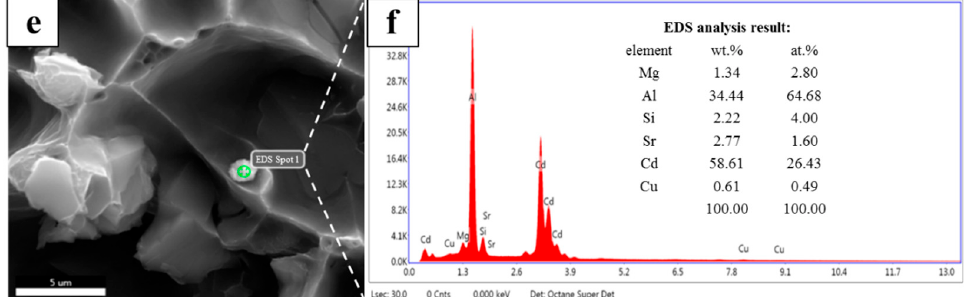
Figure 7. Fractography of the alloys after solution treatment: ( a ) two-stage-Cd-free, ( b ) two-stage- Cd-containing, ( c ) three-stage-Cd-free, ( d ) three-stage-Cd-containing, and ( e ) EDS analysis of small particles, ( f ) EDS analysis results of small particles.